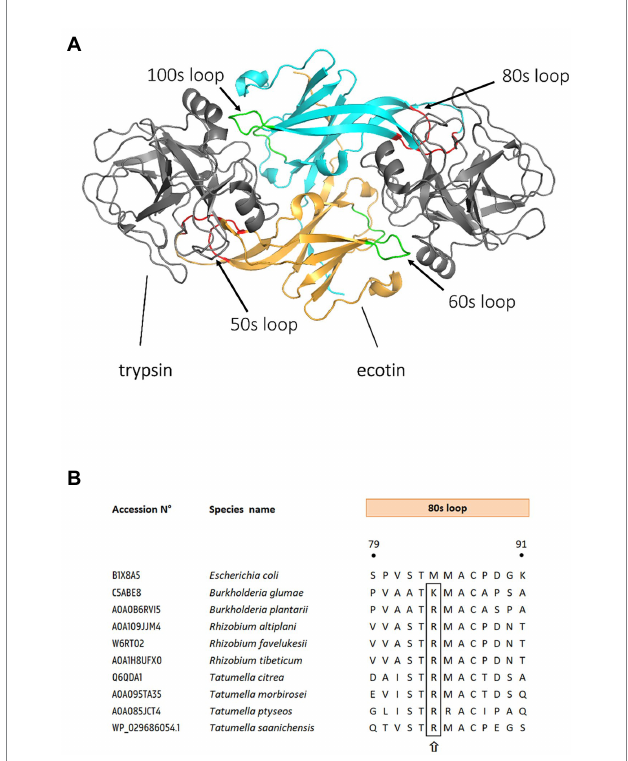
FIGURE 1 Binding sites of ecotin and ecotin-like proteins to their substrates. (A) Structure of a homodimeric ecotin in complex with trypsin protease. Ecotin (in orange and cyan) forms a stable homodimer, which binds two trypsin proteases simultaneously (in gray). The ecotin dimer contains two distinct protease-binding sites, each composed of two loops. The primary binding site (red) is composed of the 80s loop and the 50s loop, while the secondary binding site is composed of the 60s and 100 s loops (shown in green). Figure is adapted from Gillmor et al. (2000), using Protein Database (PDB) entry 1EZU. (B) Sequence alignment of ecotin orthologs primary binding site. Ecotin ortholog protein sequences were aligned, using MUSCLE (Edgar, 2004) in MEGA11 (Tamura et al., 2021). Residue position numbering is according to E. coli ecotin. The P1 position from the 80s loop (the primary specificity determinant) is designated by a upward arrow. UniProt or NCBI GenBank accession numbers are mentioned for each bacterial ecotin